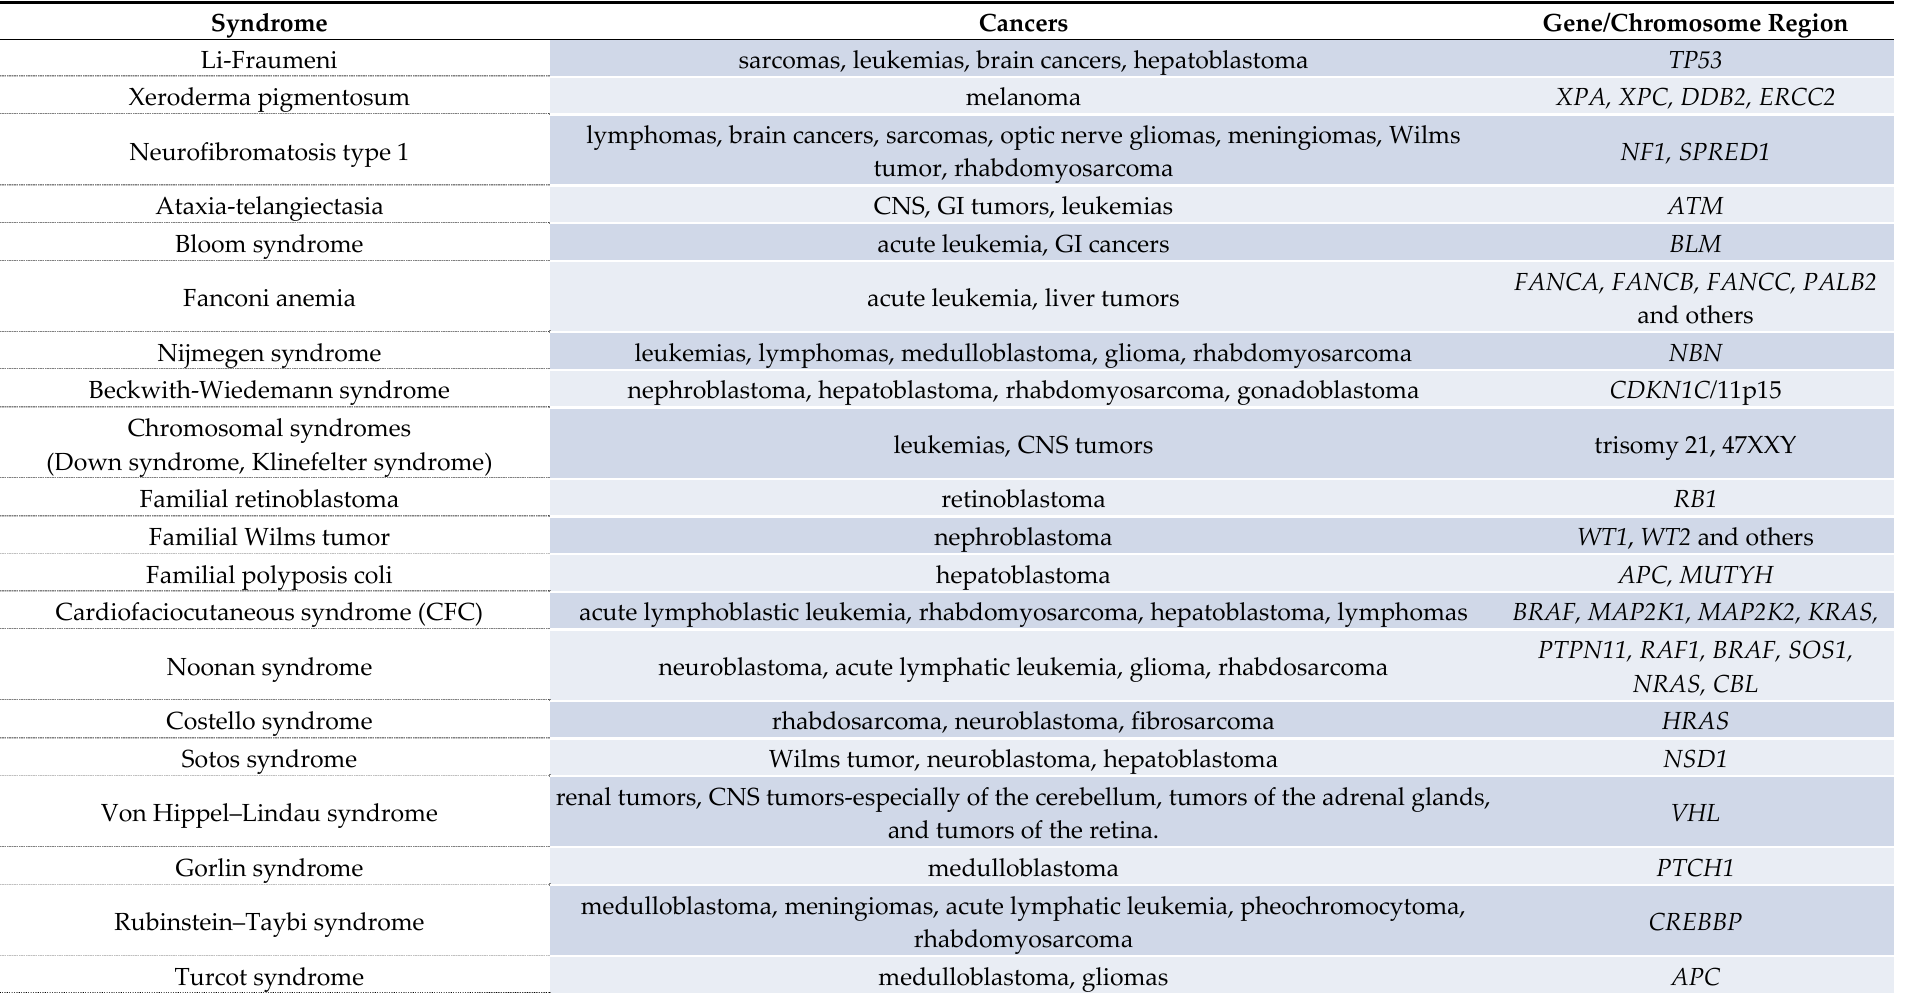
Table 11. Selected genetic syndromes associated with childhood cancers.